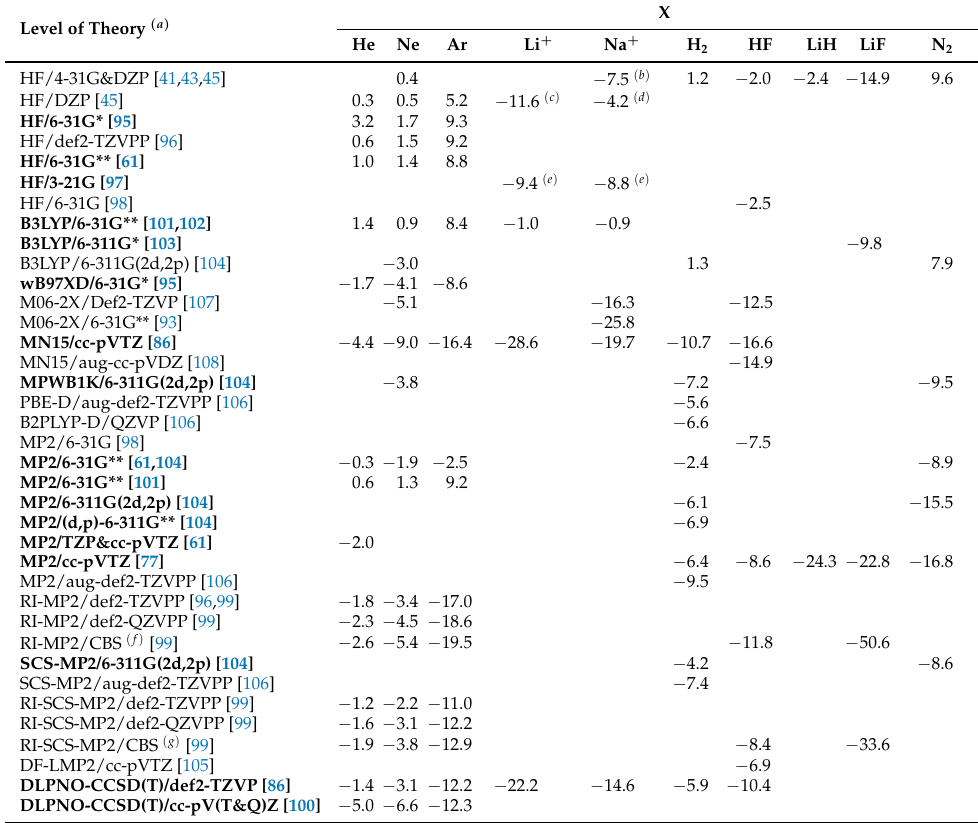
Table 2. The complexation energies [kcal/mol] of the X@C 60 species. Level of Theory ( a